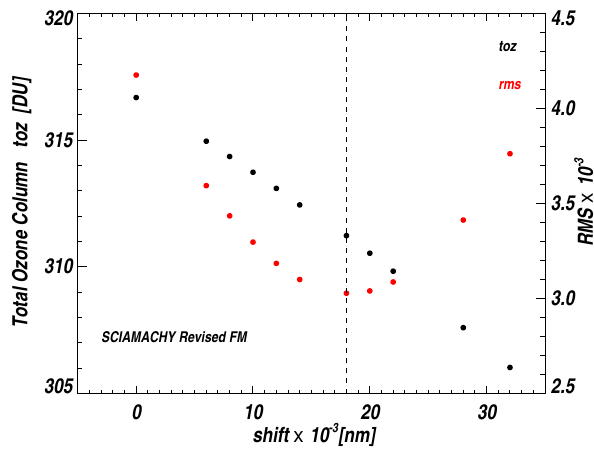
Fig. 12. Retrieved SCIAMACHY total ozone column and fit resid- uals (RMS) as a function of applied wavelength shifts to the revised SCIAMACHY FM cross sections. Minimum RMS is obtained at a shift of